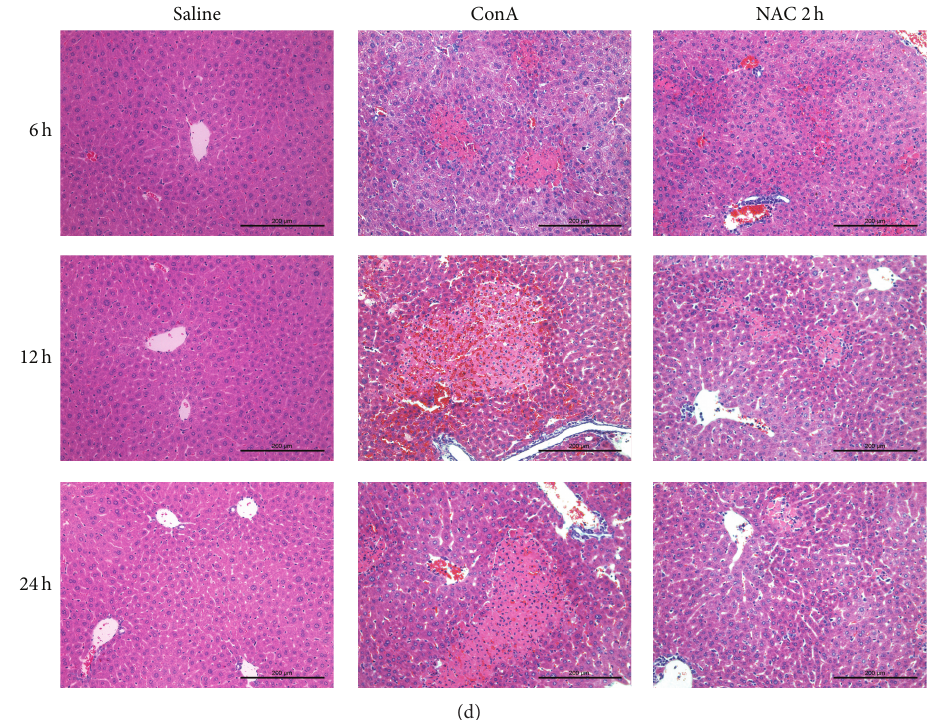
Figure 1: Effect of NAC on ConA-induced autoimmune hepatitis. (a) Effects of NAC on plasma ALT and AST levels at 6h, 12h, and 24 h after ConA injection in BALB/c mice. Data are expressed as mean ± SD ( 𝑛 = 6 ; ∗ 𝑃 < 0.05 for ConA versus NAC 30 min (post-NAC-treated, 30 min after injection with ConA); # 𝑃 < 0.05 for NAC 30 min (post-NAC-treated, 30 min after injection with ConA) versus NAC 2 h (NAC- pretreated, 2h before injection with ConA)). (b) Photomicrographs of representative livers collected 6, 12, and 24 h after ConA injection and stained with hematoxylin and eosin (H&E), × 200 magnification. (c) Effects of NAC on plasma ALT and AST levels at 6h, 12h, and 24 h after ConA injection in C57 mice. Data are expressed as mean ± SD ( 𝑛 = 6 ; ∗ 𝑃 < 0.05 for ConA versus control group; # 𝑃 < 0.05 for ConA versus NAC 2 h (NAC-pretreated, 2 h before injection with ConA)). (d) In C57 mice, photomicrographs of representative livers collected 6, 12, and 24 h after ConA injection and stained with hematoxylin and eosin (H&E), × 200